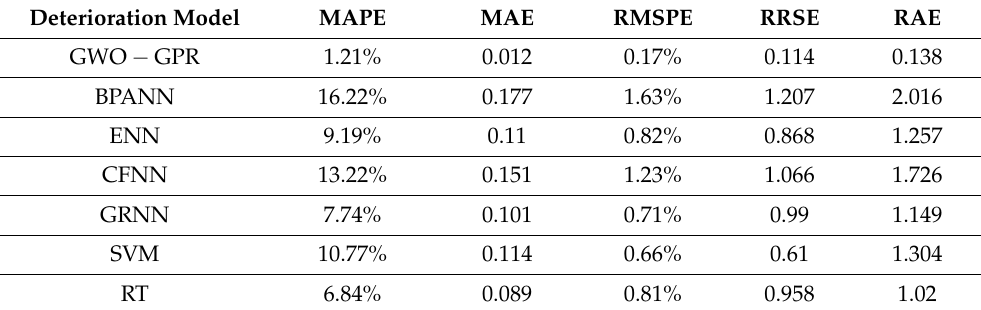
Table 7. Performance comparison between deterioration prediction models of concrete slab on